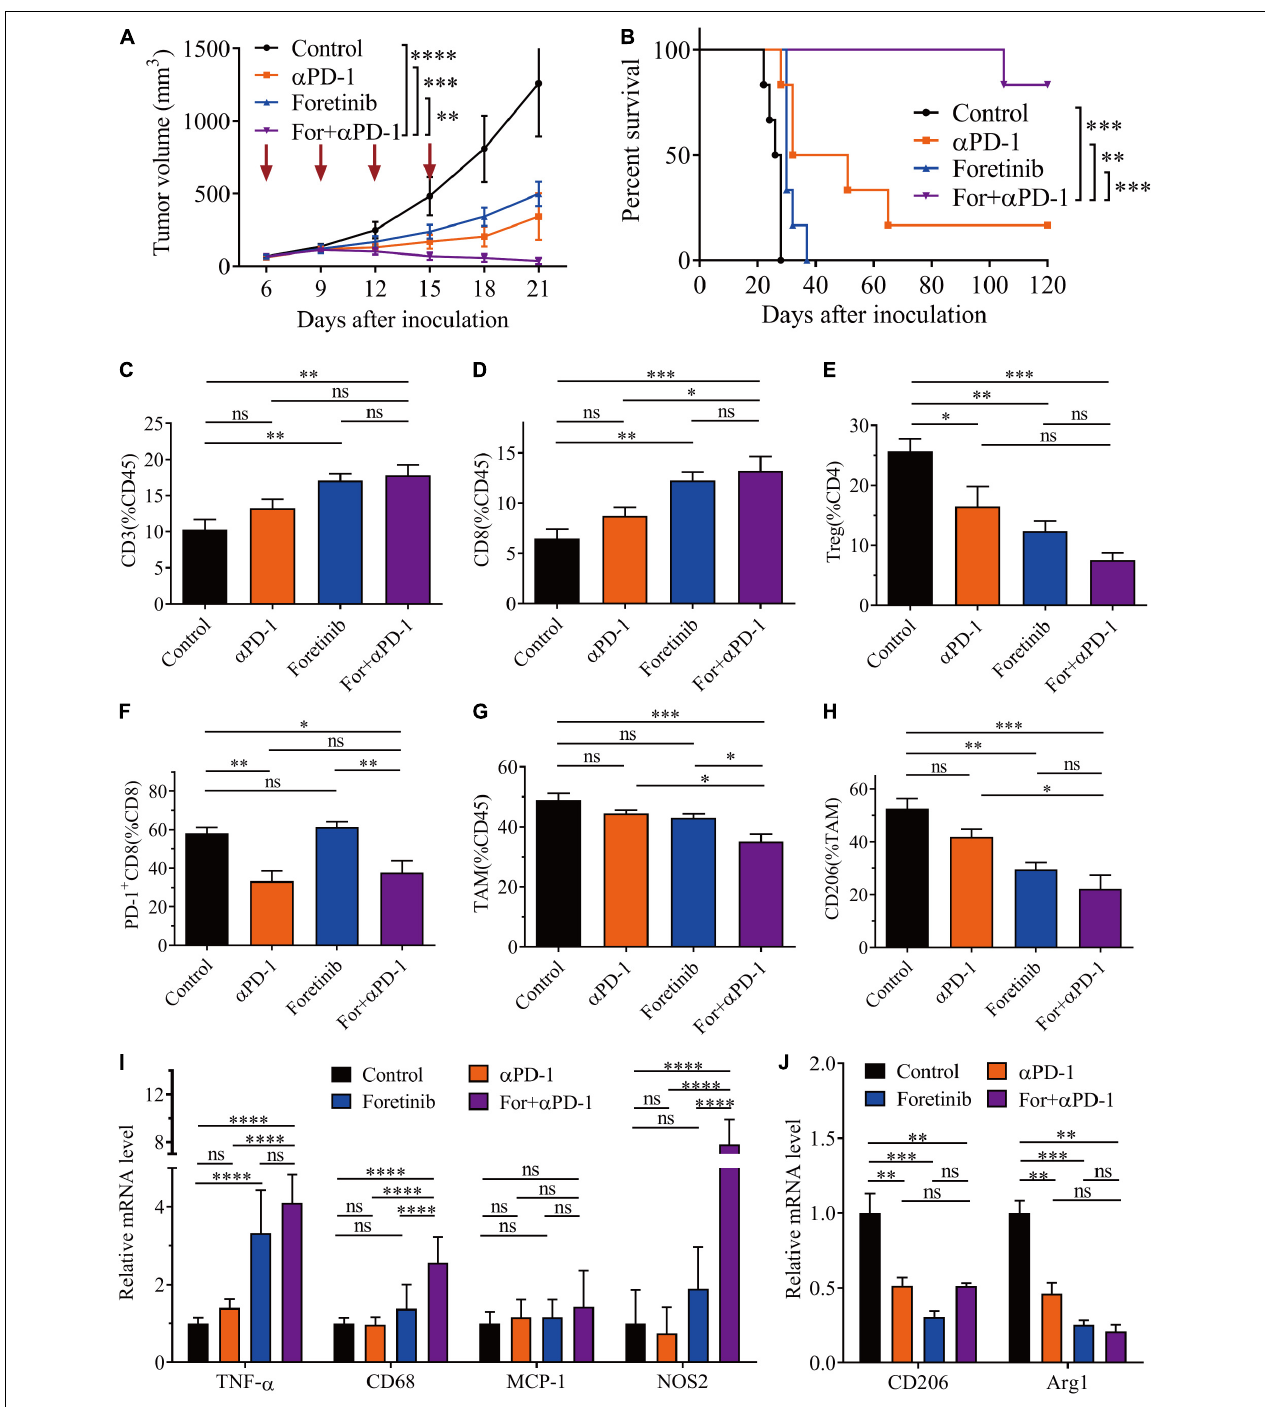
FIGURE 5 | Combination therapy ameliorated the TME in CT26 tumors. CT26 cells (5 × 10 5 ) were transplanted subcutaneously into the back of BALB/c mice. When the tumor volume reached 50–100 mm 3 (6 days after transplantation), the mice were randomly allocated to either the control or treatment groups. The drugs were given as described in “Materials and Methods” section. (A) Tumor volumes were monitored every 3 days and (B) the Kaplan–Meier survival distribution was plotting for the mice following the treatment protocol ( n = 6). After treatment, the infiltration of CD3 + T cells (C) , CD8 + T cells (D) , and Tregs (E) , plus the expression of co-inhibitory molecules (PD-1) on CD8 + T cells (F) was detected via FCM. The percentage of TAMs (G) and the expression of CD206 on TAMs (H) was detected by FCM ( n = 5). (I,J) qRT-PCR analysis of TAM function-associated gene expression ( n = 4). The data is presented using the mean ± SEM where applicable, * ( P ≤ 0.05), ** ( P ≤ 0.01), *** ( P < 0.001), **** ( P < 0.0001), and ns (no statistical significance, P ≥ 0.05).